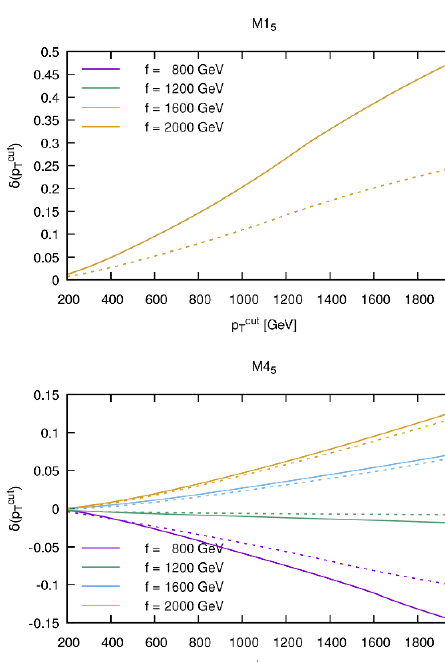
Figure 18 . The distribution (cid:14) ( p cut section 3.2.